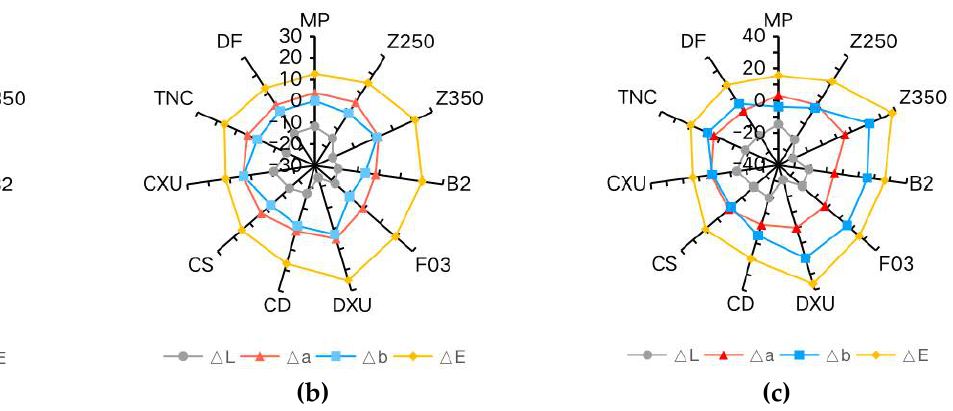
Table 3. Mean and SD of CIE L*, a*, and b* parameters of composite resins after immersion in solu- tions for 28 days.